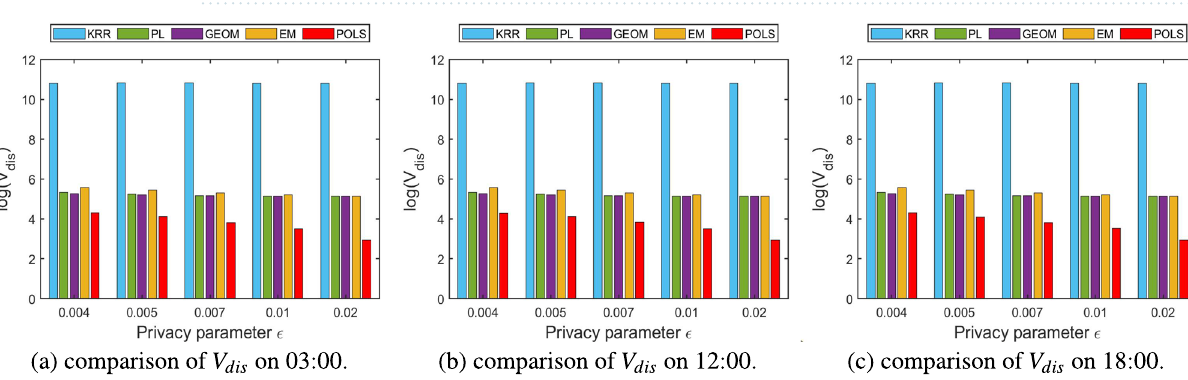
Figure 8. Comparison of V dis among different perturbation